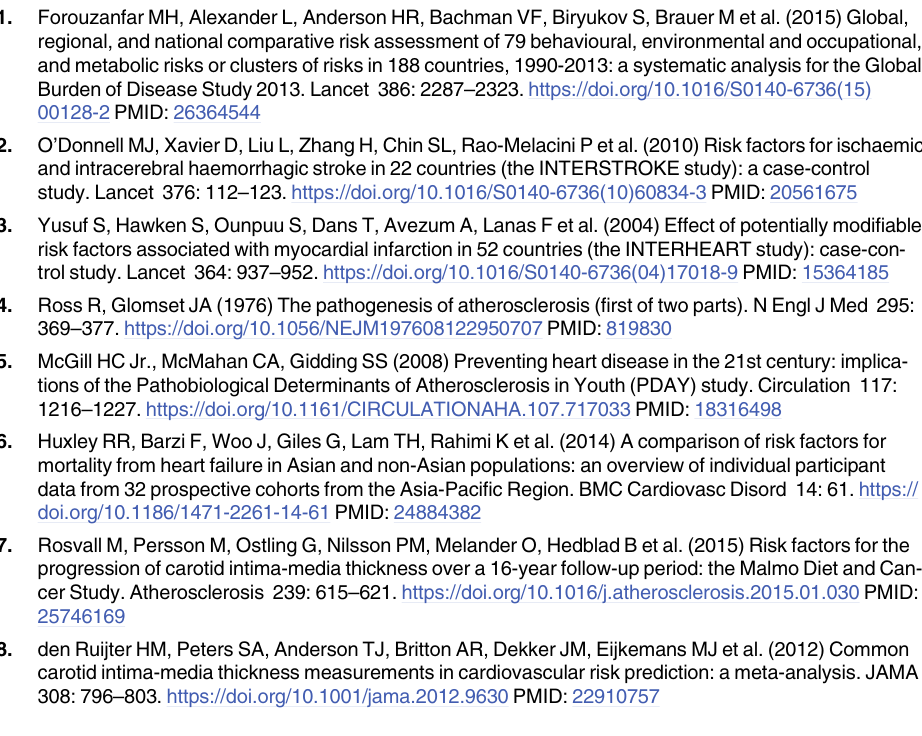
S2 Fig. Relation between risk factor clusters and CIMT (by race-ethnic group). Each cluster was compared to individuals without any risk factor (reference group). CIMT, mean com- mon carotid intima media thickness. BP, elevated blood pressure; OW, overweight; TC, ele- vated total cholesterol; smoking, current smoking.